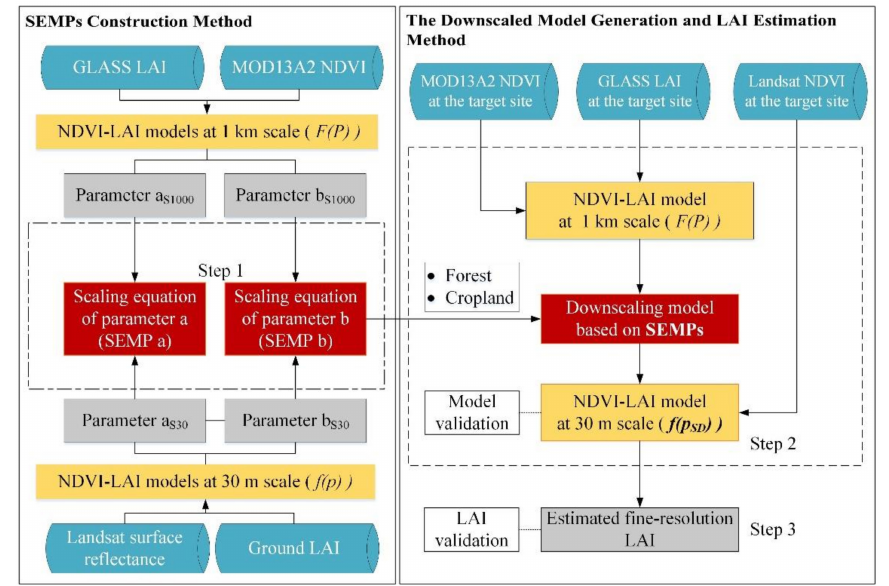
Figure 2. Flowchart of a model-downscaling methodology based on scaling equations of model parameters for fine-resolution leaf area index (LAI)